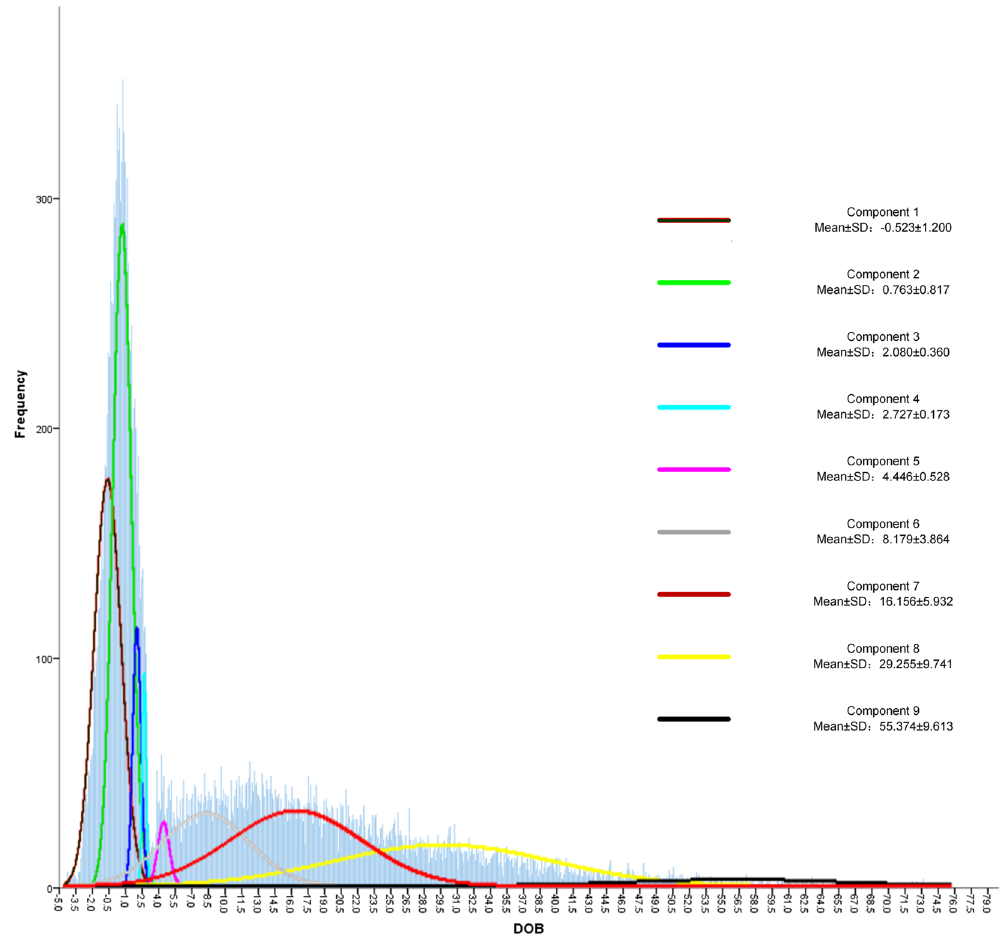
Figure 1. Distribution of DOB value with density line of 9 components modeled by finite mixture model in the modelling population.